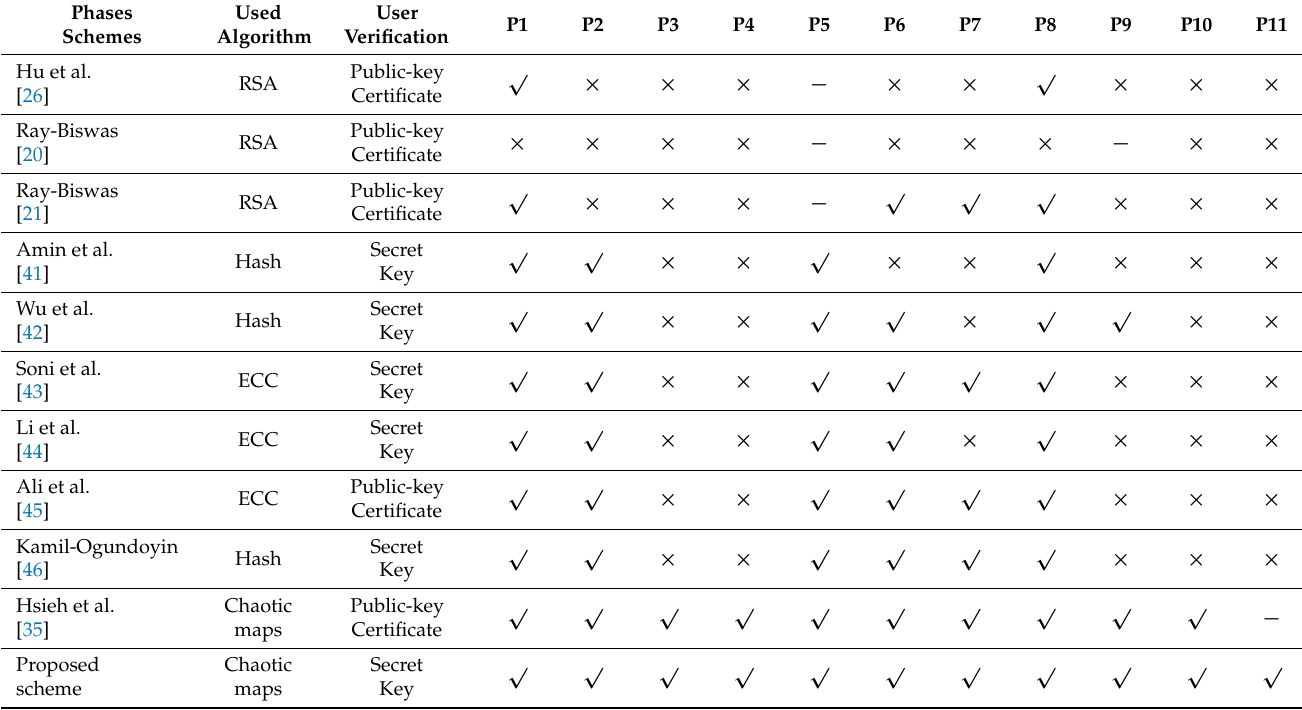
Table 3. Functionality